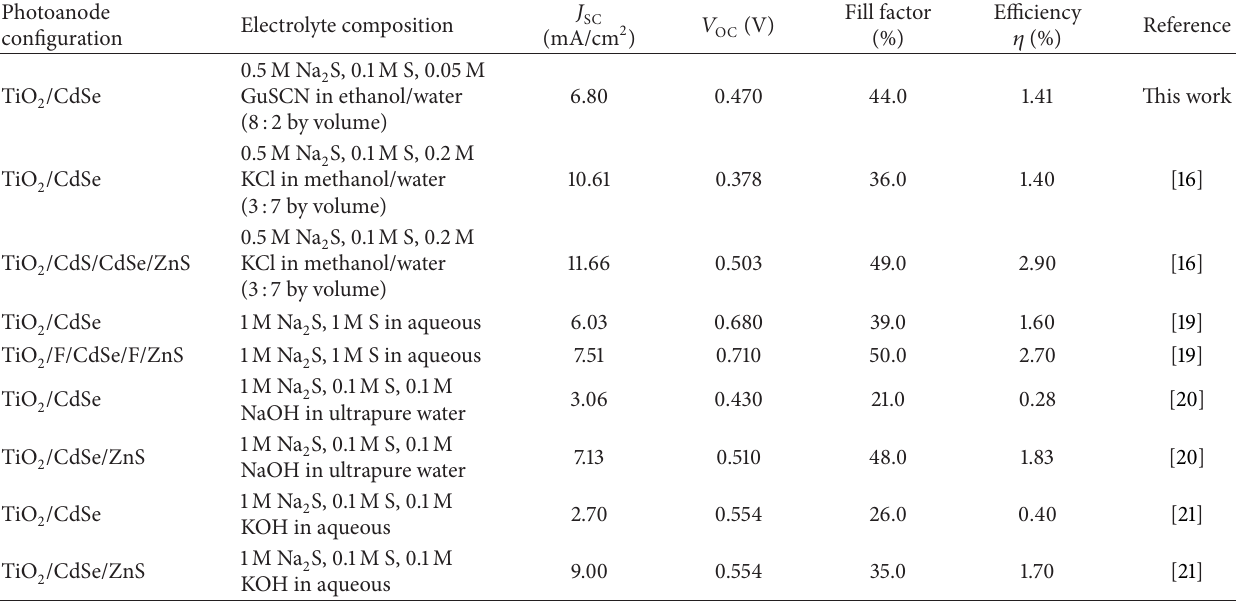
Table 6: Performance parameters of CdSe QDSSC with different polysulfide electrolyte compositions reported by various groups. Photoanode